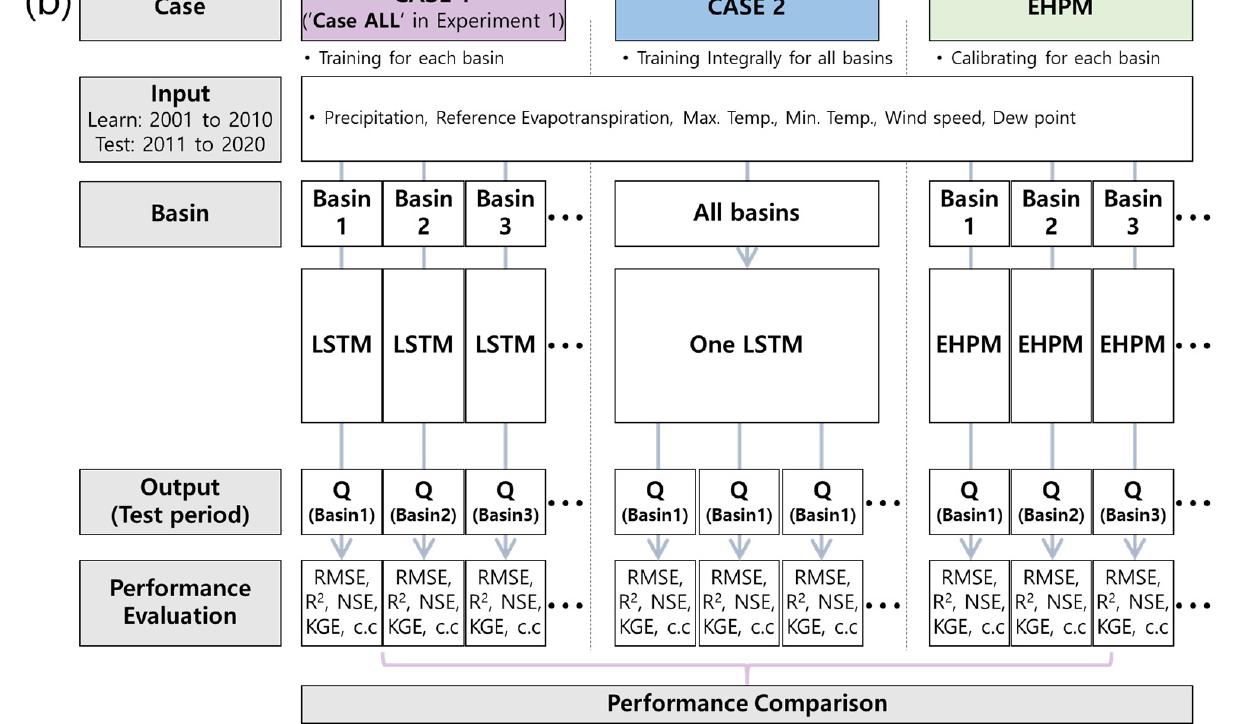
Figure 3. Flowchart for: ( a ) experiment 1; and ( b ) experiment 2.